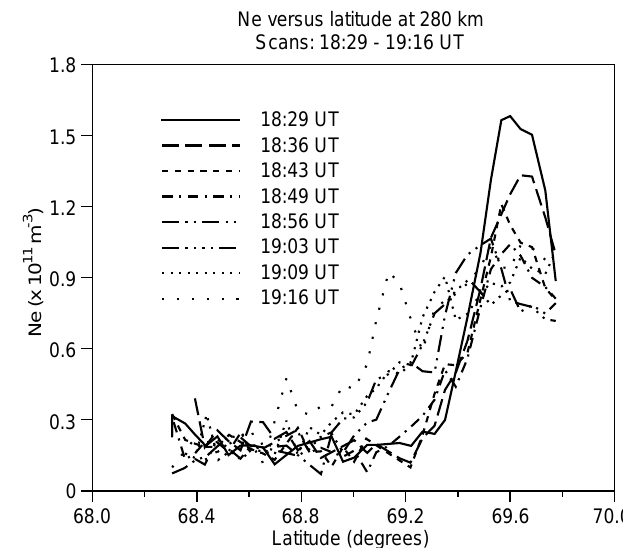
Fig. 3. Electron densities as a function of latitude for four selected heights measured by the radar during the scan commencing at 1836 UT